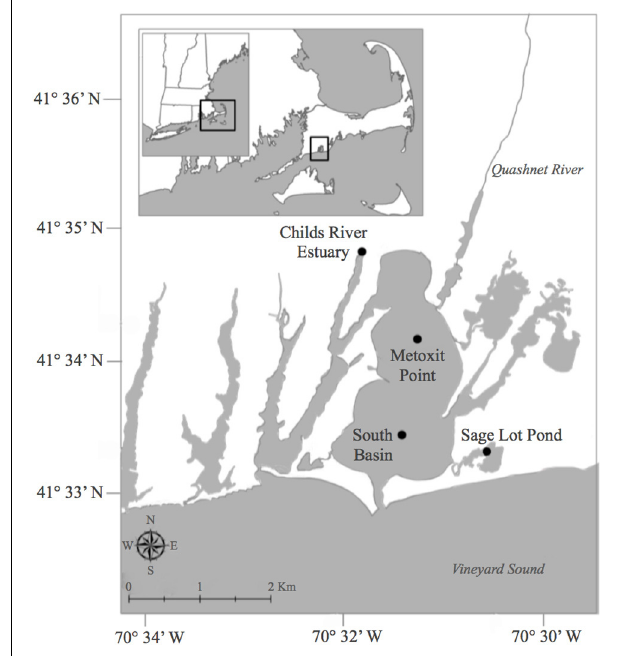
FIGURE 1 | Map of sampling locations during 2011 and 2012 for benthic oxygen, dissolved inorganic nitrogen, and net di-nitrogen sediment flux measurements in Waquoit Bay, Cape Cod, Massachusetts, USA. Stations include; Childs River Estuary (CRE), Metoxit Point (MP), South Basin (SB), and Sage Lot Pond (SLP). Historic studies in the early 1990s measured benthic oxygen and nitrogen fluxes (LaMontagne, 1996; LaMontagne et al., 2002) at two of these stations, CRE and SLP. Map created by S. Q. Foster. GIS data layers are from the Office of Geographic Information (MassGIS, www.mass.gov/mgis/massgis.html, December 2011,) and are registered to the NAD83 datum, Massachusetts State Plane Mainland Zone coordinate